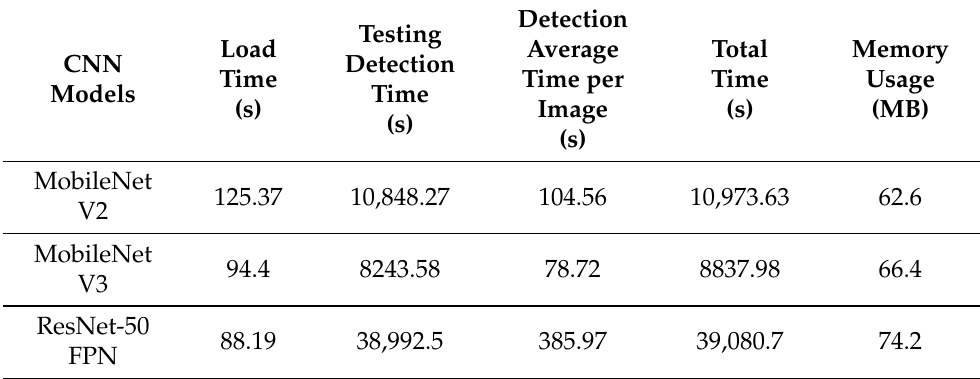
Table 2. Experimental Scenario I; end node device operating in offline mode (4 core-ARM CPU) detection time and memory usage.